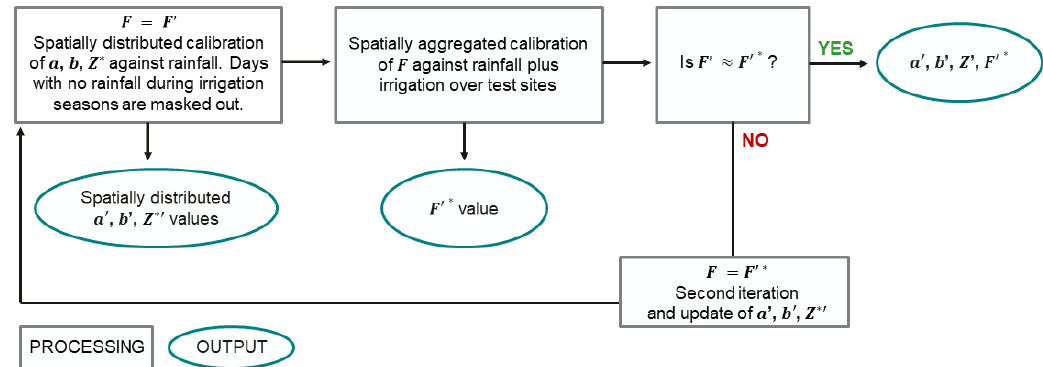
Figure 2. Iterative procedure adopted to calibrate the SM-based inversion algorithm parameters a,b,Z ∗ , and F .